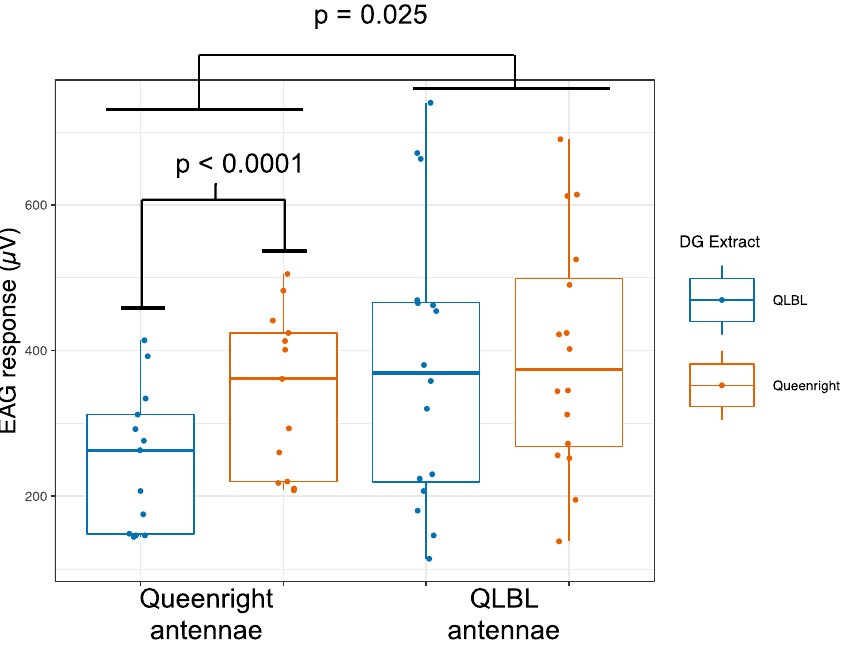
Figure 6. Electroantennogram responses (µV) of queenless brood-less and queenright worker antennae to Dufour’s gland extracts (1 worker equivalent) from queenless brood-less and queenright workers. Blue and orange boxplots represent responses to queenless brood-less and queenright Dufour’s gland extracts, respectively. Asterisks indicate significance (*p < 0.05, ***p <